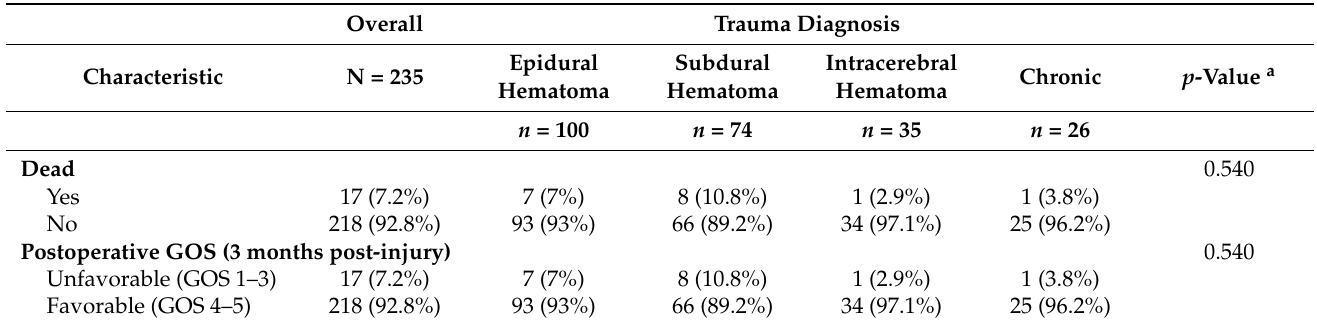
Table 3. Trauma Diagnoses and Outcome Measures.